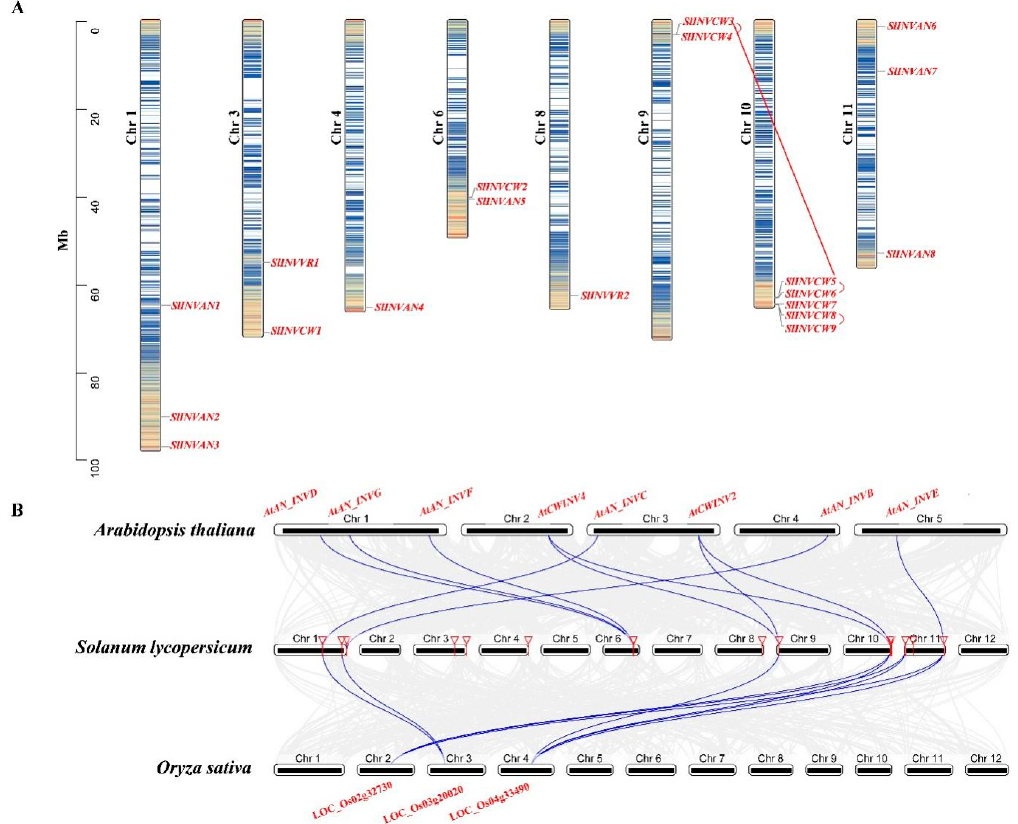
Figure 5. Chromosome localization of tomato INV genes ( A ) and synteny analysis of INV genes from tomato, Arabidopsis and rice ( B ). The red arc lines indicate tandem duplicated gene pairs, and the red straight line indicates segmental duplicated gene pair. Chr, chromosome.